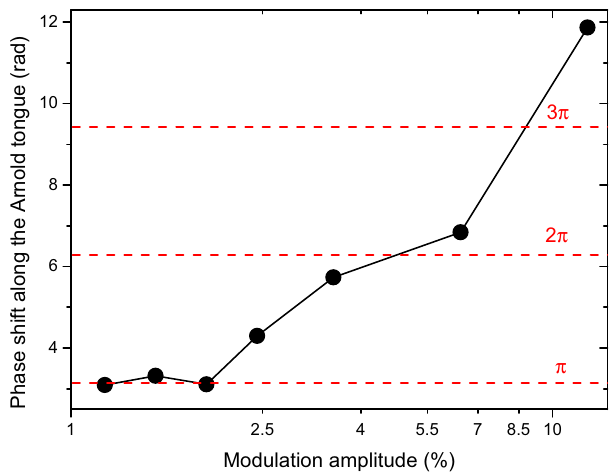
Fig. 7 Accumulated phase difference across the width of the Arnold tongue versus the modulation percentage. The plotted values account for the overall phase shift of the transmission curve with respect to the reference signal when going across the injection-locking frequency range. Dashed red lines highlight integer multiples of π .